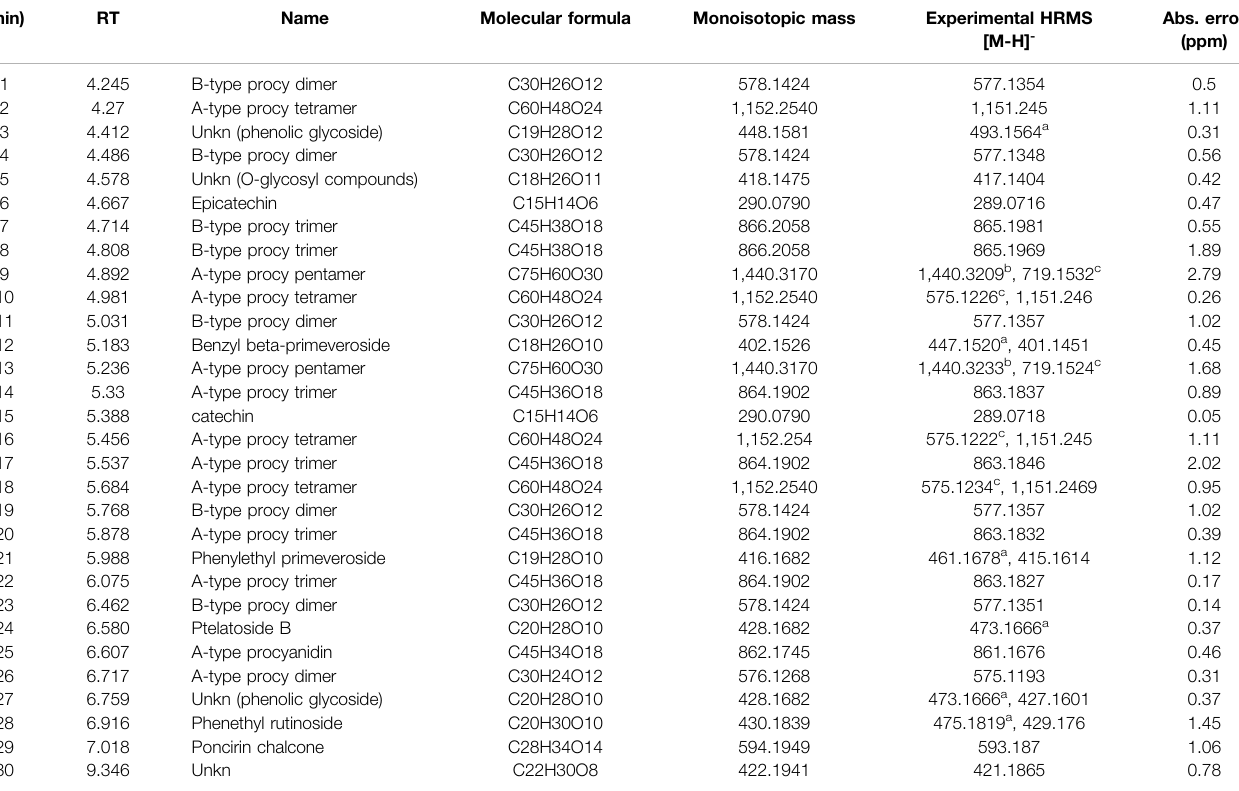
TABLE 4 | UPLC/HR-MS data for the major extract components identi fi ed in fraction B was obtained from the CCHE extract. (min)